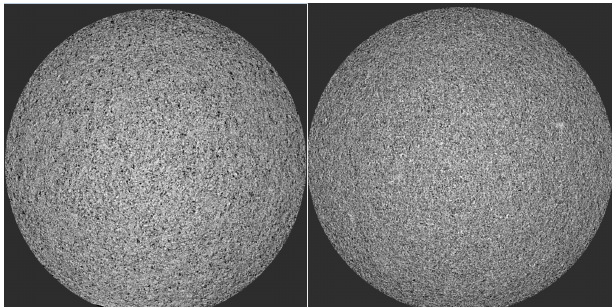
Figure 14. MicroXCT (4× magnification) of the spray dried material ( right ) and fluid bed material ( left ) concerning the same model drug (BCS II API).